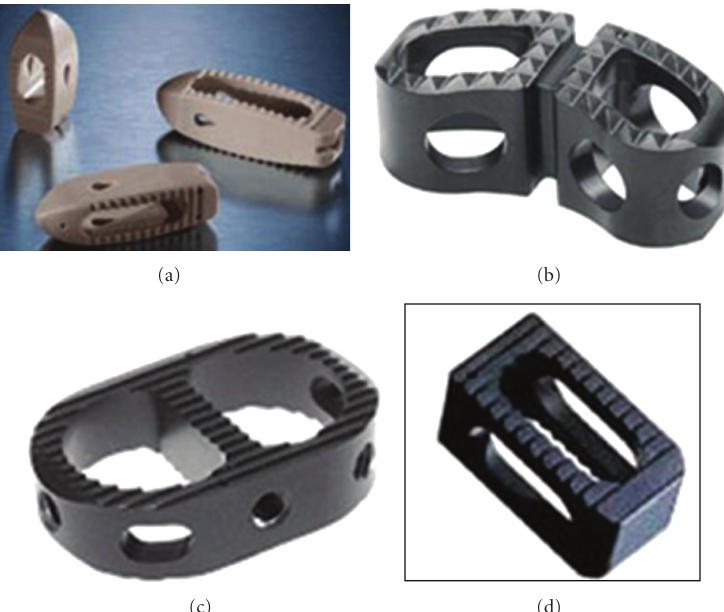
Figure 2: Rigid interbody cages. (a) Ardis (Zimmer spine, Minneapolis, MN, USA), (b) Leopard (DePuy, Raynham, MA, USA), (c) Cougar (DePuy, Raynham, MA, USA), and (d) Jaguar (DePuy, Raynham, MA, USA) (website).